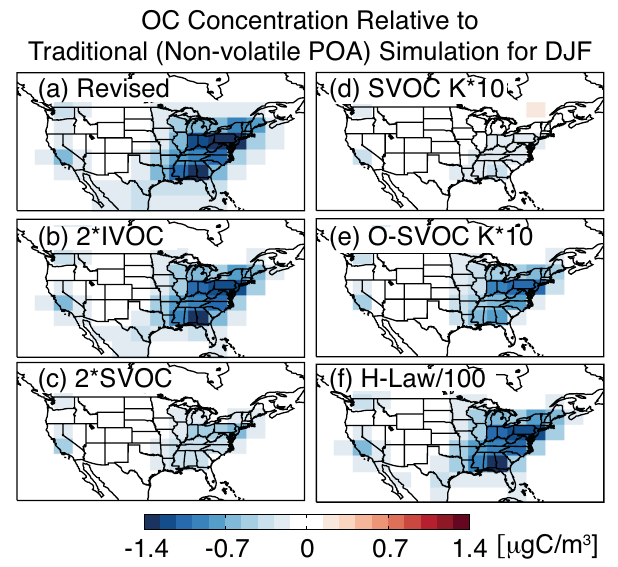
Fig. 8. DJF surface total OC concentration (POA, SOA from SVOCs, SOA from IVOCs, and traditional SOA) relative to non- volatile POA simulation (POA and traditional SOA) using GISS meteorology at 4 ◦ × 5 ◦ . Sensitivity tests are given in Table 6.